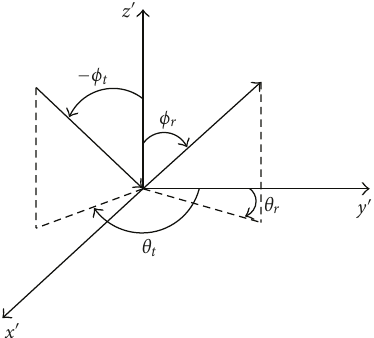
Figure 2: Definitions of incident and observed